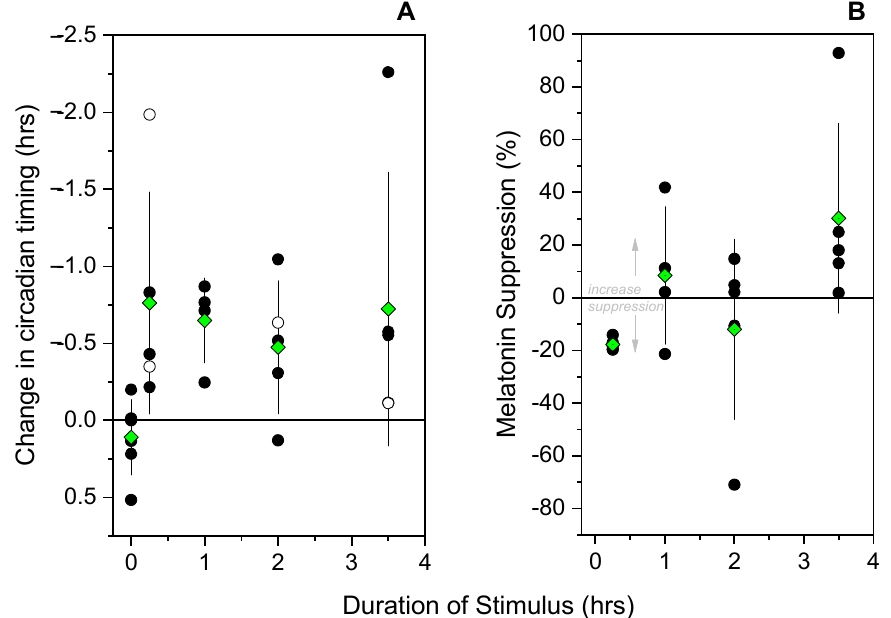
Figure 3. Phase shifting in response to light flash sequences of different durations. Left panel ( A ): The magnitude of the shift in the timing of the onset (phase) of melatonin ( ∆ φ ) is plotted against the duration of the flash sequence and compared to a historic protocol control (8) in which individuals were awakened into darkness and not given a light stimulus (0 h data). Right panel ( B ): The magnitude of the change in acute melatonin concentrations between the beginning and the end of the flash stimulus. Individual data (black discs) are displayed along with group average (green diamonds) with SD bars. The open discs indicate the four participants in whom a fixed, rather than dynamic, threshold was used to determine circadian timing.